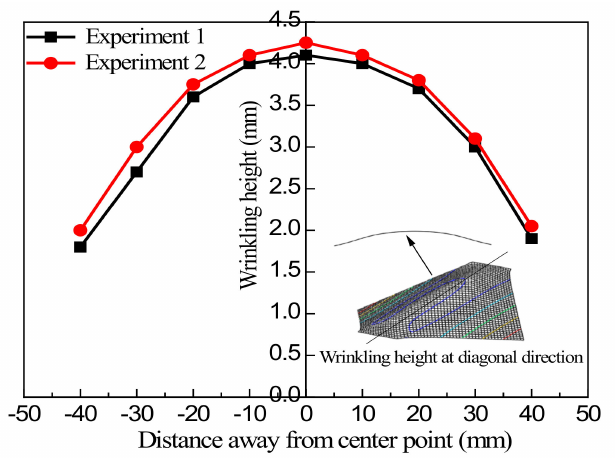
Figure 17. Comparison of measurements of wrinkling height of samples in the main diagonal direction.